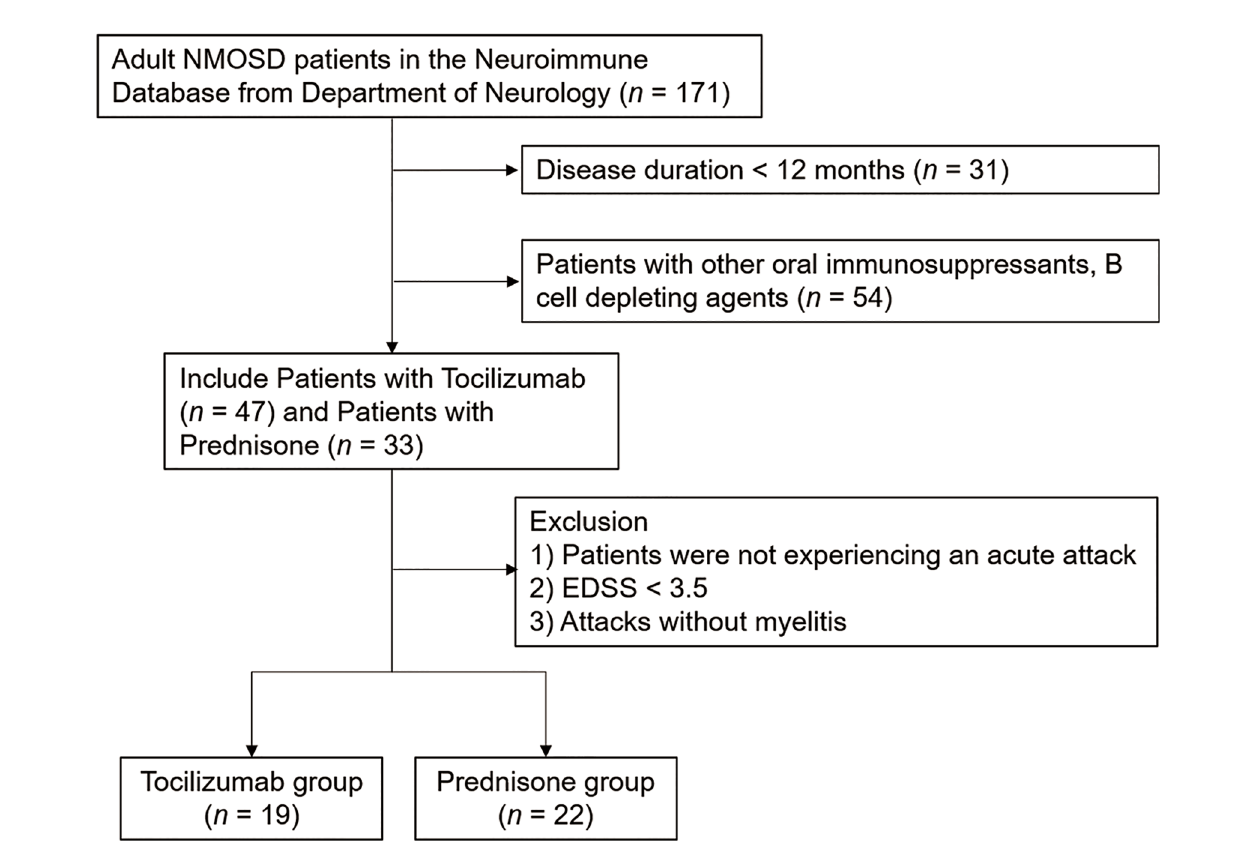
FIGURE 1 | Flowchart of the patients enrolled in the study. The patients were retrospectively enrolled between June 1, 2017 and July 1, 2020. All patients were admitted to the Department of Neurology, Tianjin Medical University General